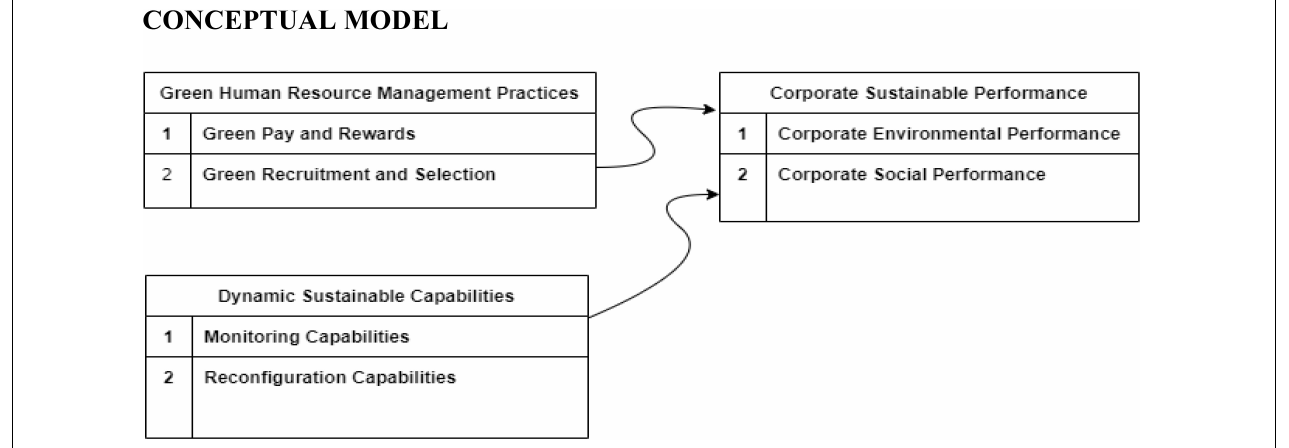
FIGURE 1 | Conceptual framework (author’s development). Inspiration is taken from Amrutha and Geetha (2019) and Nisa et al. (2019).